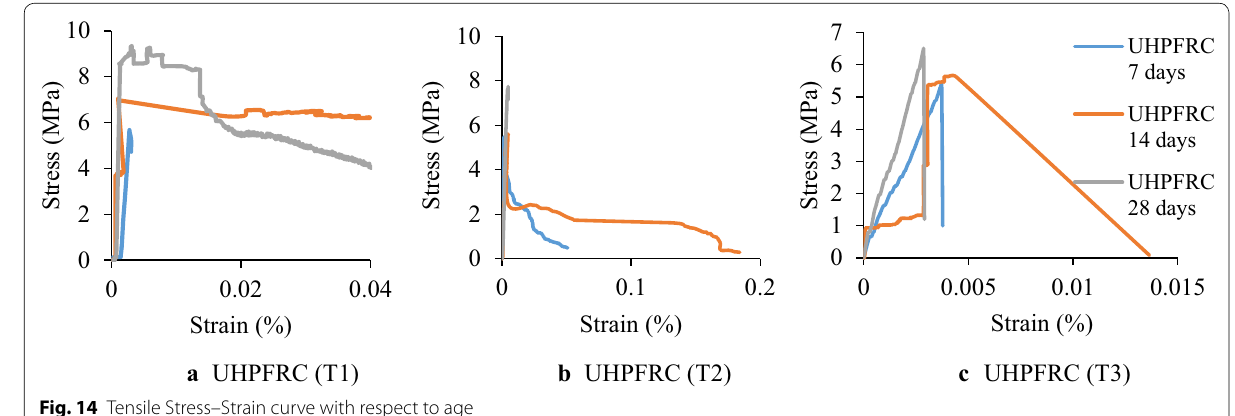
Fig. 14 Tensile Stress–Strain curve with respect to